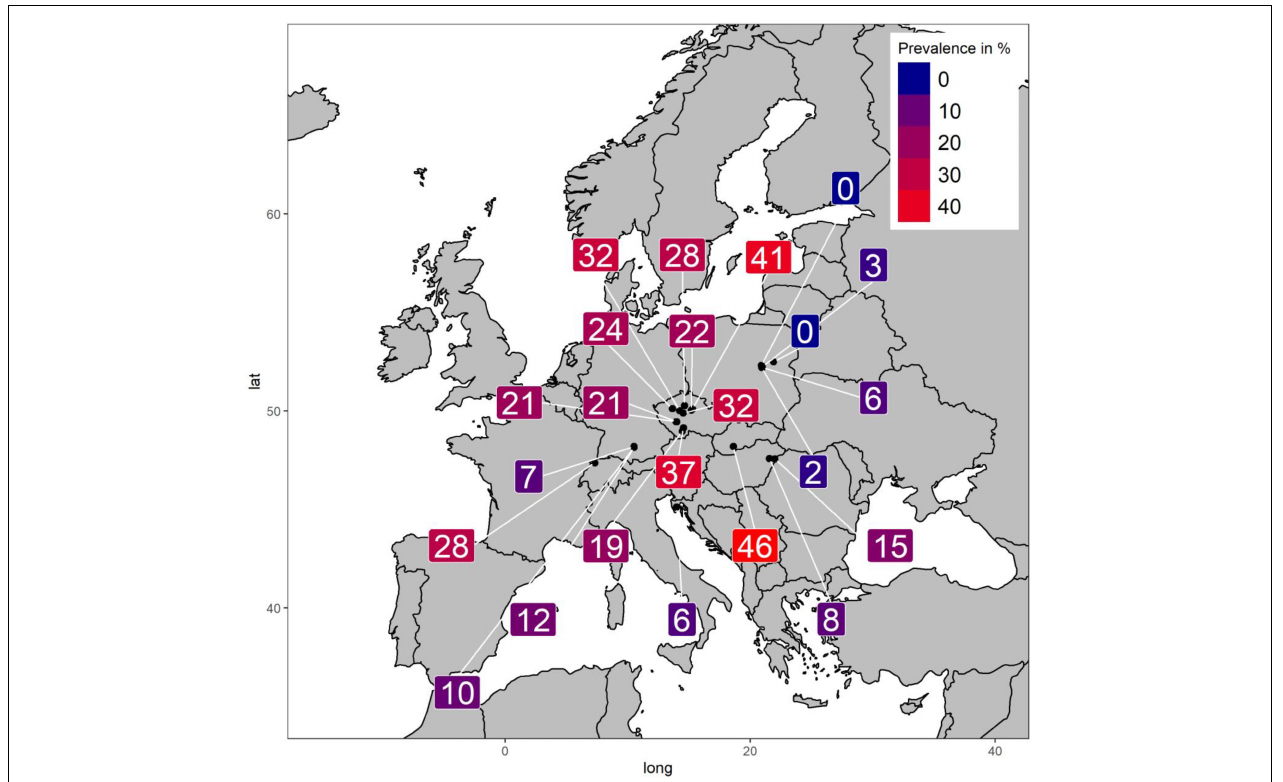
FIGURE 1 | Parasite prevalence by sampled